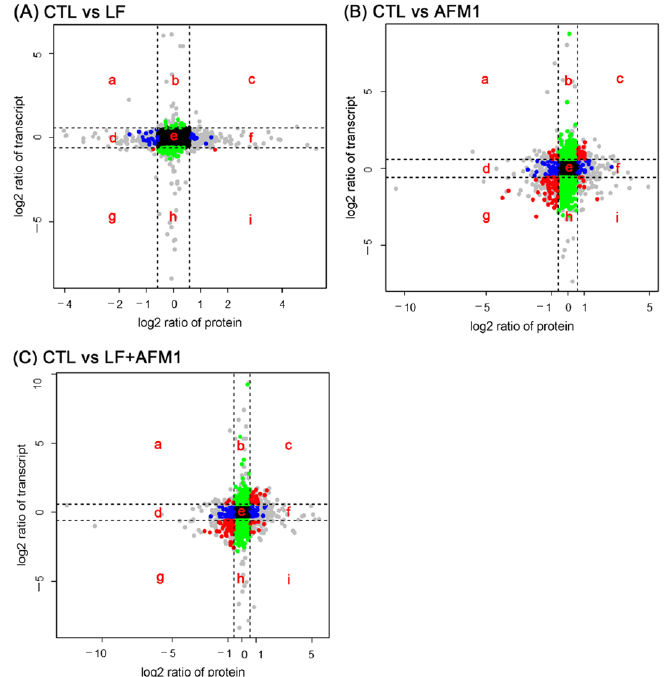
Figure 7. Correlation between identified transcripts and proteins in differentiated Caco-2 cells. ( A ) Cells exposed to LF, ( B ) cells exposed to AFM1 and ( C ) cells exposed to the combination of LF and AFM1. Black points (area e) represent no significant changes at both mRNA and protein levels. Blue points (area d, f) represent the significant changes at the protein level. Green points (area b, h) represent significant changes only at the transcript level. Red points (area a, c, g and i) represent significant changes in mRNA and protein levels. Gray points (area a, b, c, d, f, g, h and i) represent the transcripts or proteins meeting the criterion of p > 0.05 and fold change > 1.5.